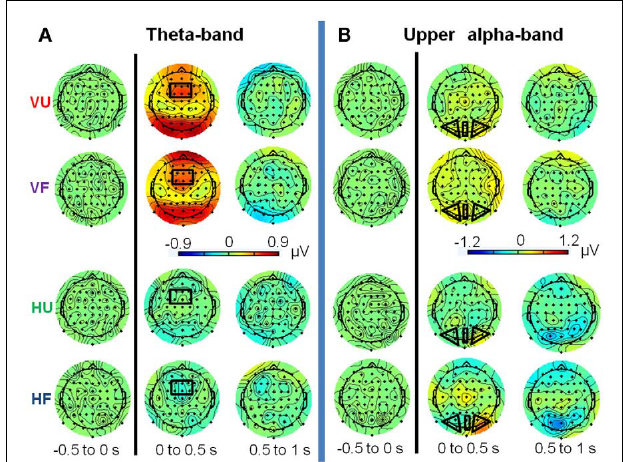
FIGURE 8 |Topographical plots of evoked theta-band [(A); 5–7Hz] and upper alpha-band [(B); 10–12Hz] activity for the visual and haptic object recognition tasks. Plots are displayed in 500ms time segments, from − 500 to 1000ms, with the black line indicating stimulus onset.VU, visual unfamiliar;VF, visual familiar; HU, haptic unfamiliar; HF, haptic familiar. Note: different scales for the bands.